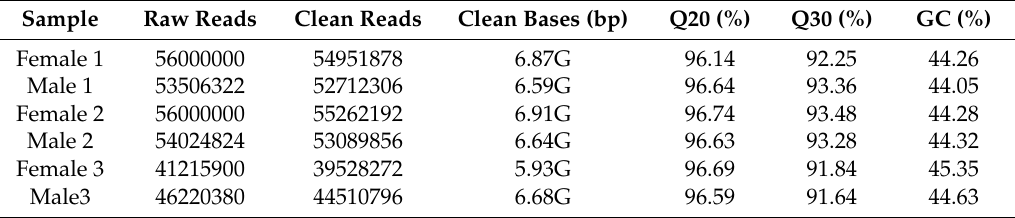
Table 2. Results of quality statistics of transcriptome database of Pinus bungeana